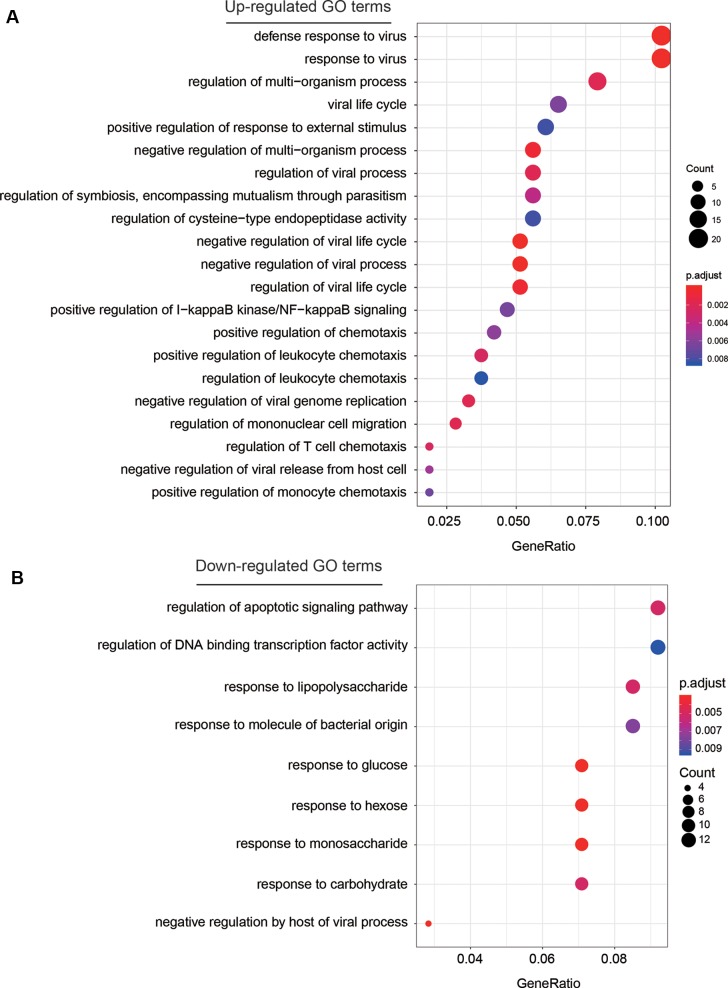
The GO terms enriched by dysregulated genes. The GO terms enriched by up-regulated and down-regulated genes are displayed in (A) and (B), respectively. The more the gene count, the larger size the circle.